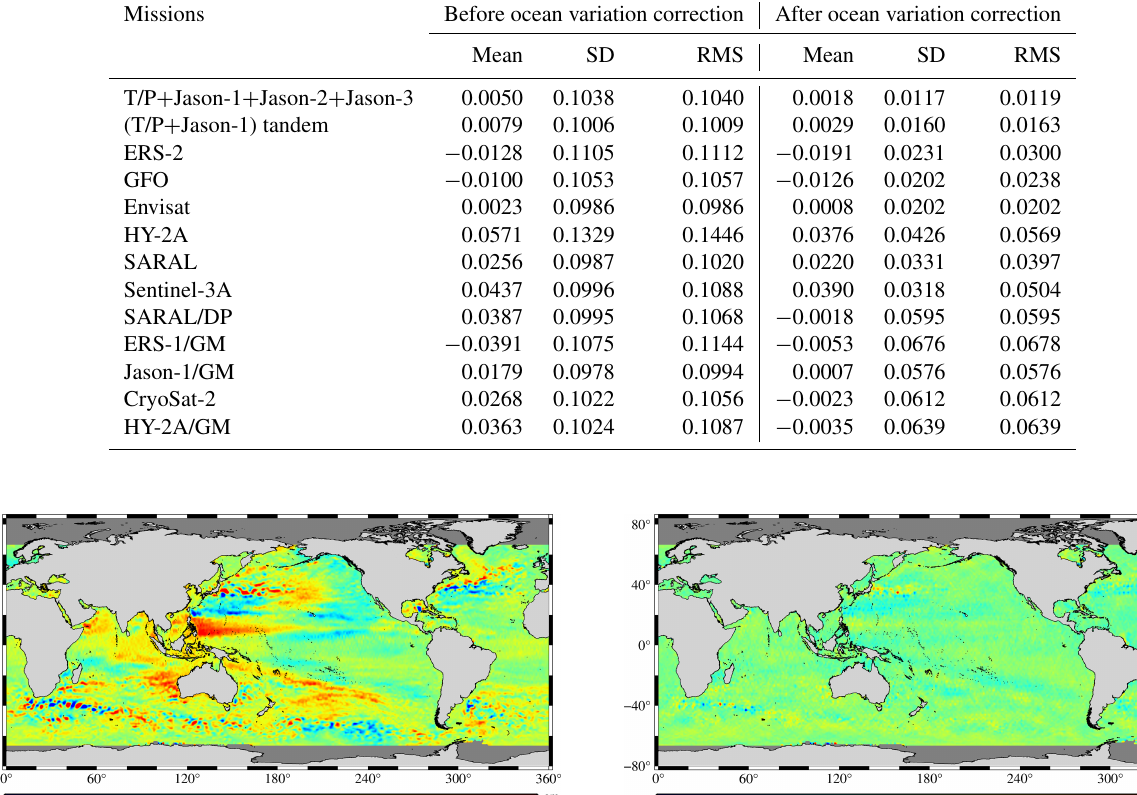
Table 2. Statistical results of the comparison between heights of different altimeter missions and the SDUST2020 model before and after oceanic variability correction (unit: m).